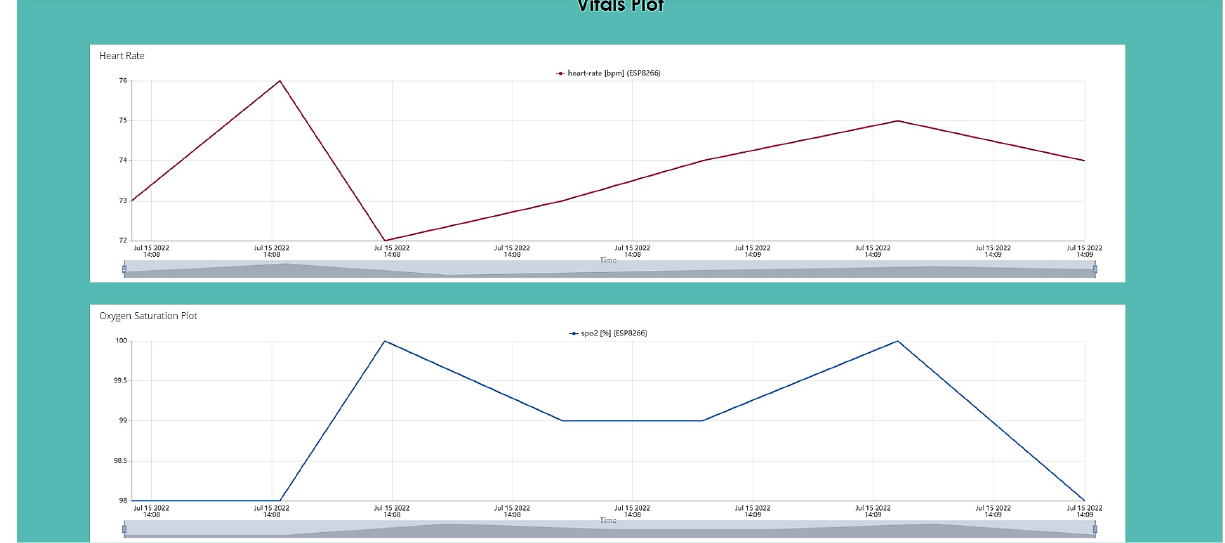
Figure 8. Data visualization on the website.